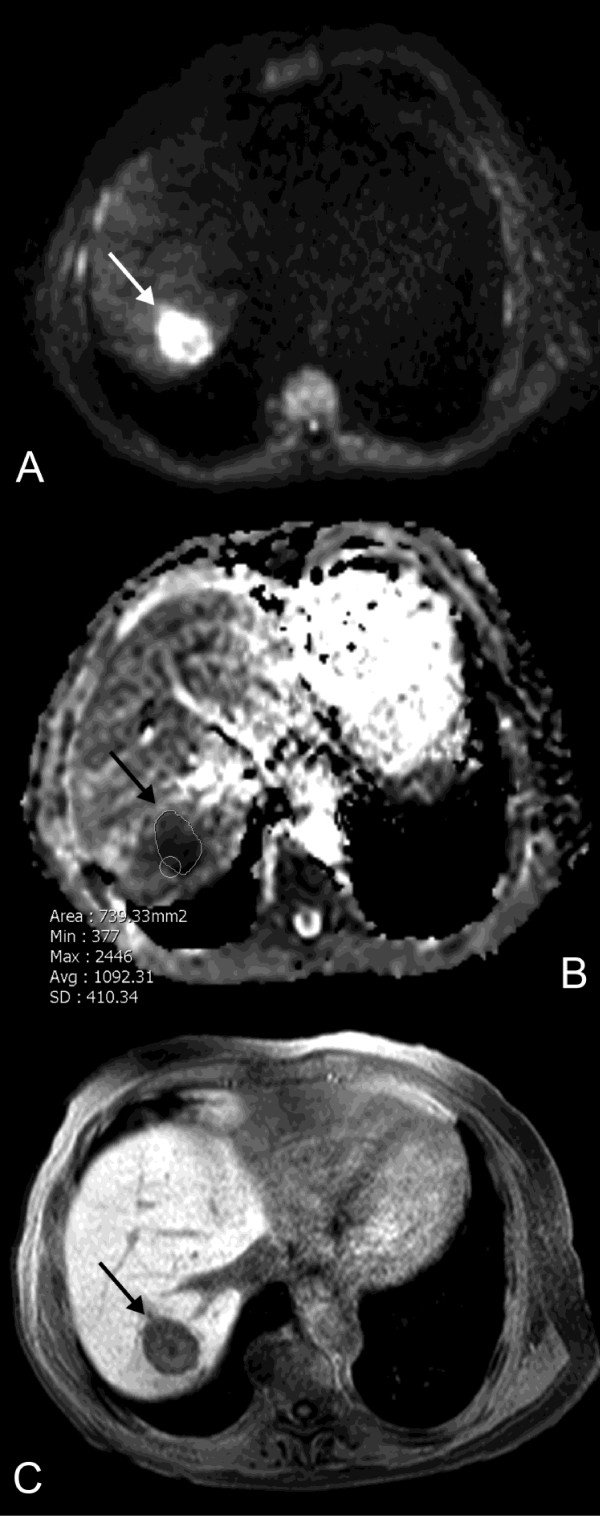
Early MRI 3 days after HDR-BT. Early DWI (A) and corresponding ADC map (B) performed 3 days after HDR-BT (same patient as in Figure 1) reveal a decrease in mean ADC by 27.1% to 0.94 × 10-3 mm2s-1. The ROI within the lesion indicates an ADC value of 1.09 × 10-3 mm2s-1 in this slice of the ADC map (arrow). T1w Gd-EOB-DTPA enhanced MR image in hepatobiliary phase (C) indicates no relevant change in size of the treated lesion (24.1 cm3).